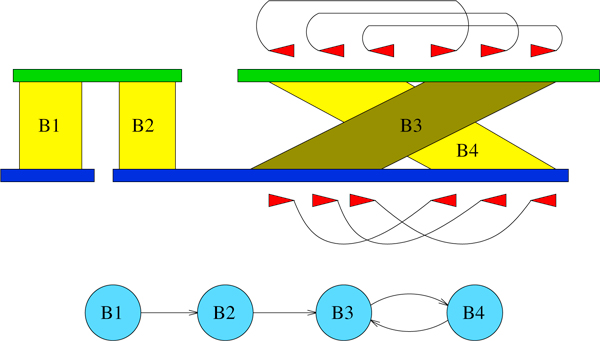
Handling 2-node cycles in Assemblies Graph. A 2-node cycle in AG witness a putative inversion along a single contig in M and S. If there actually is an inversion, then mate-pair reads are aligned with the wrong orientation in one of the two contigs. We can use this information to provide in output a correct sequence (the blue one in the picture).